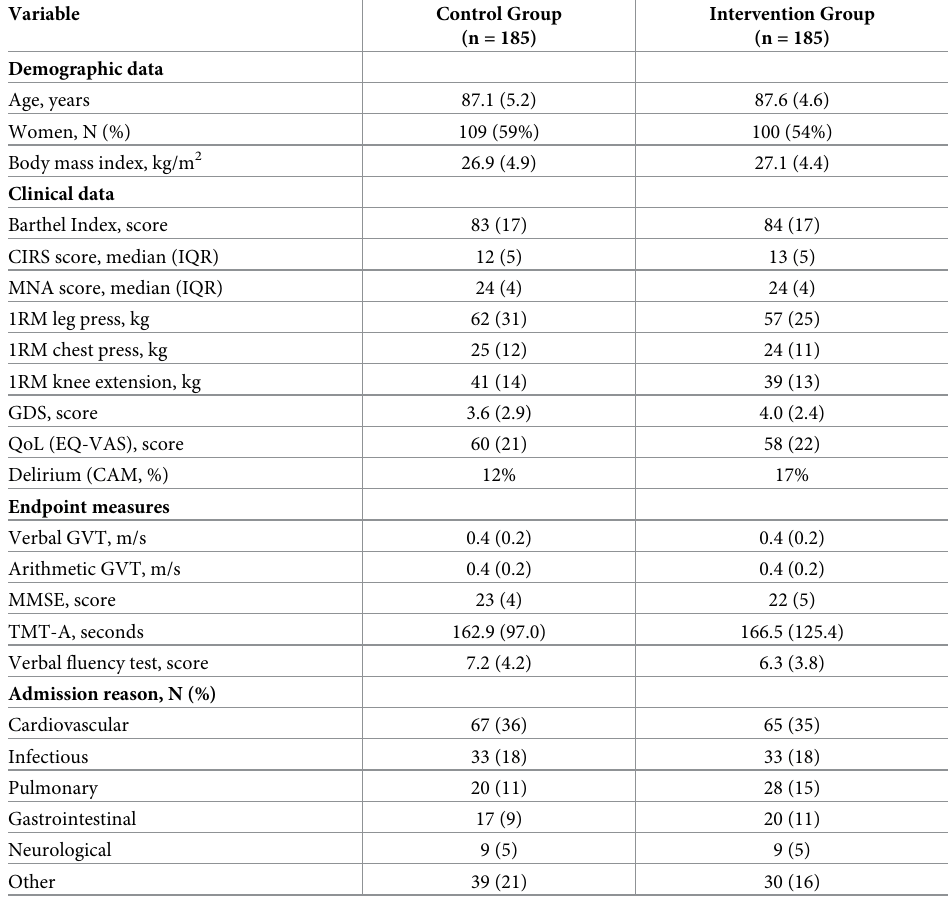
Table 1. Baseline characteristics of the